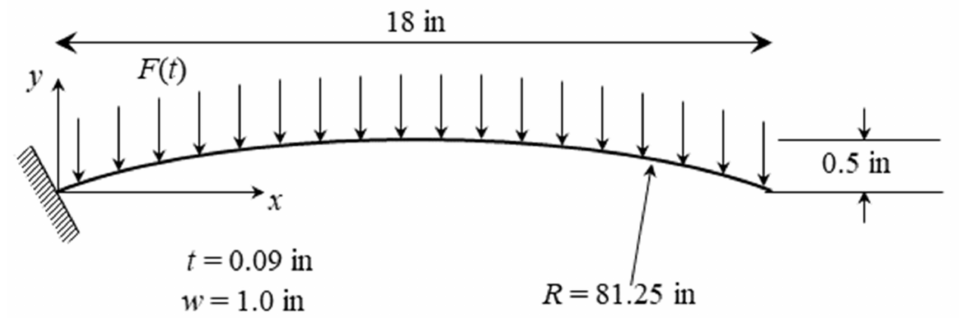
Figure 1. Cantilevered curved beam geometry.